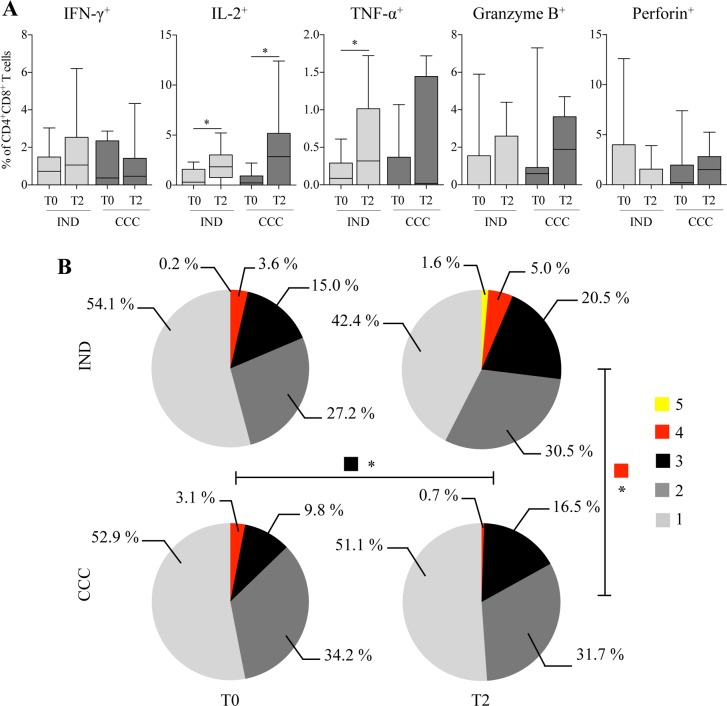
Impact of benznidazole on the functional and multifunctional capacity of T. cruzi-specific CD4+CD8+ T cells.The longitudinal study was carried out in IND and CCC patinets.(A) Frequency of CD4+CD8+ T cells producing IFN-γ, IL-2, TNF-α, perforin or granzyme B against TcSA in IND and CCC before (T0) and 24–48 months after treatment. (B) Impact of the treatment on the multifunctional activity profiles of T. cruzi-specific CD4+CD8+ T cells in IND and CCC. Results obtained before (T0) and after treatment (T2). The color in the pie charts depicts the number of molecules produced by CD4+CD8+ T cells in response to T. cruzi antigens. Statistical analyses were carried out using the Wilcoxon and permutation test. Statistically significant differences are indicated by (*) ρ<0.05. The cChD was grouped into IND (n = 9) and CCC (n = 10).